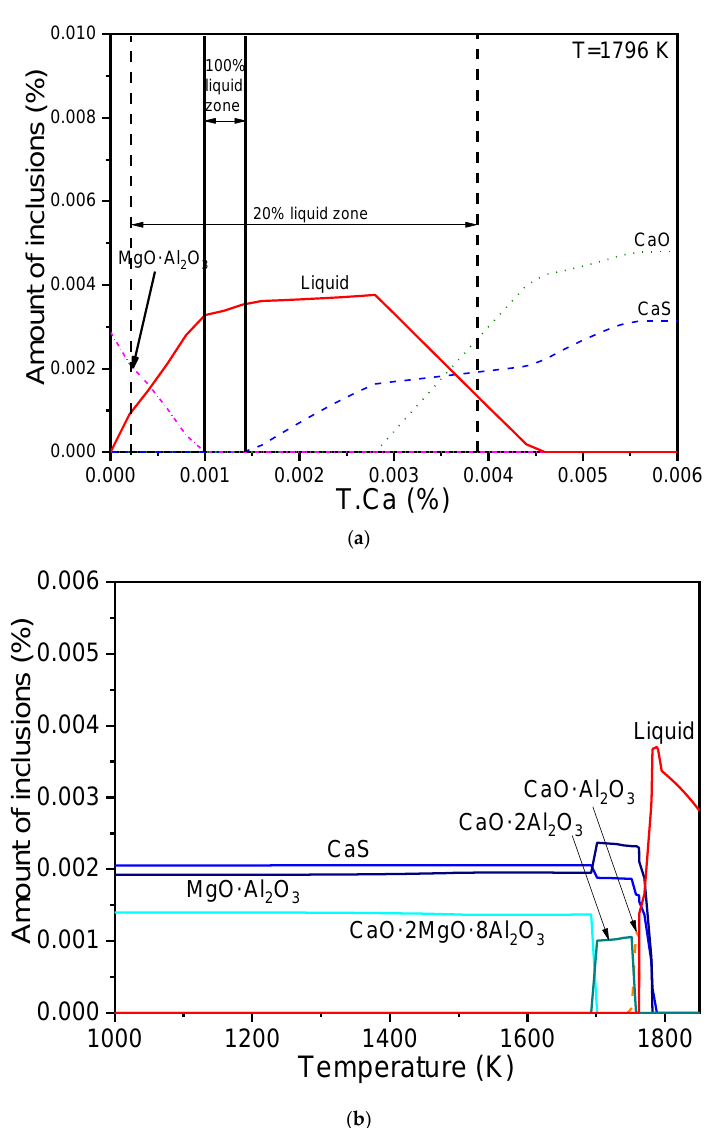
Figure 12. Transformation of inclusions in the Al-killed Ca-treated steel with various calcium concentration and temperature. ( a ) effect of calcium concentration, ( b ) effect of temperature.